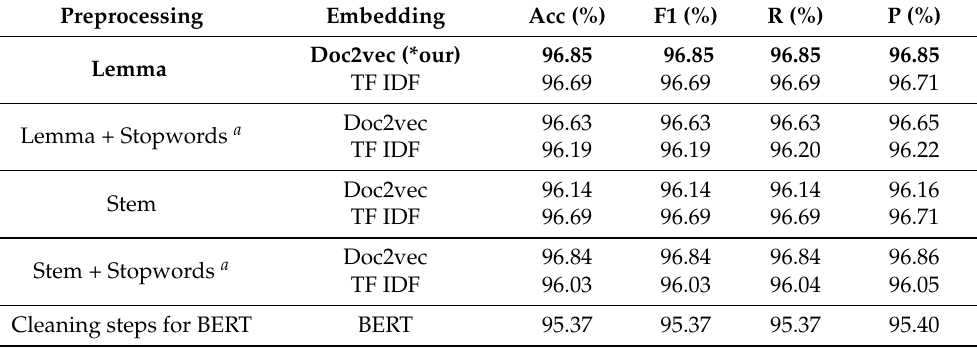
Table 7. Comparison of preprocessing, embedding and SVM model results.